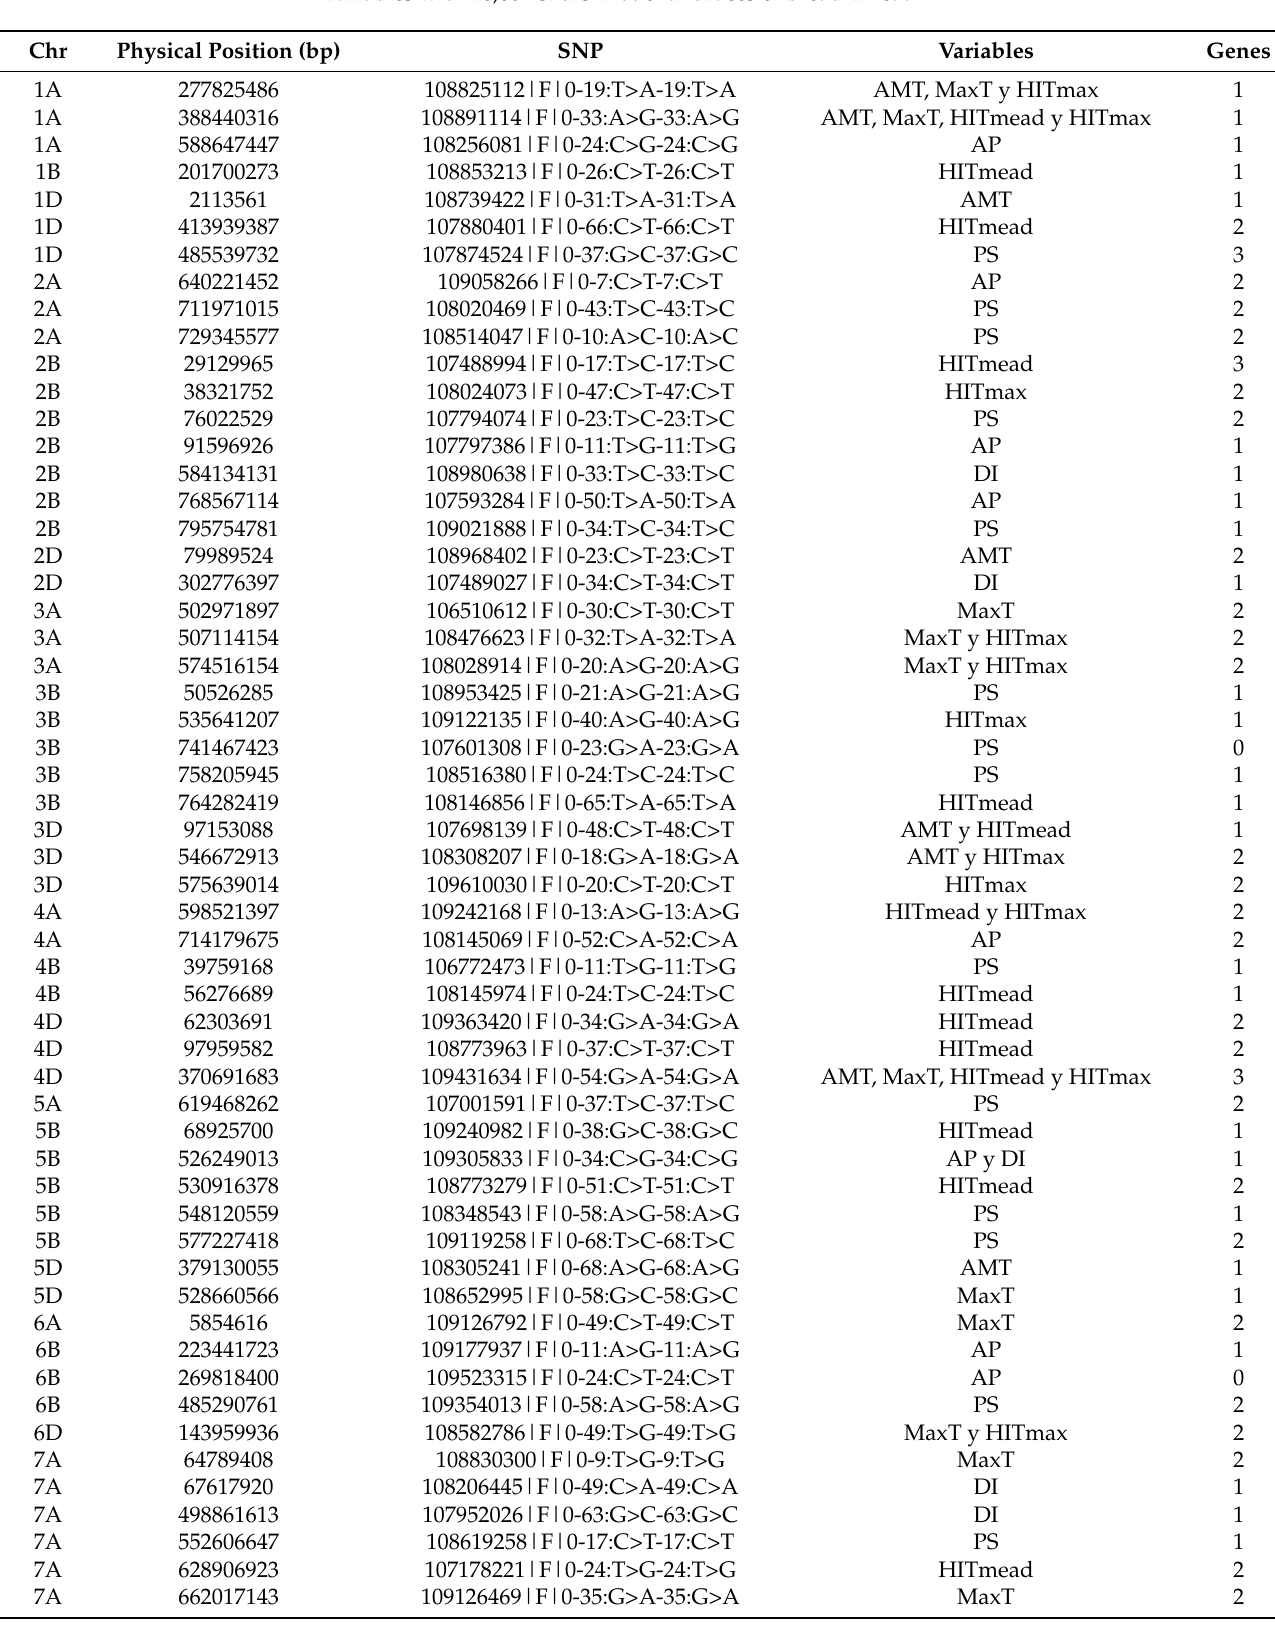
Table 2. Number of genes detected from Genome–environment Associations (GEA) for seven climatic variables with 26,064 SNPs in 990 landraces of bread